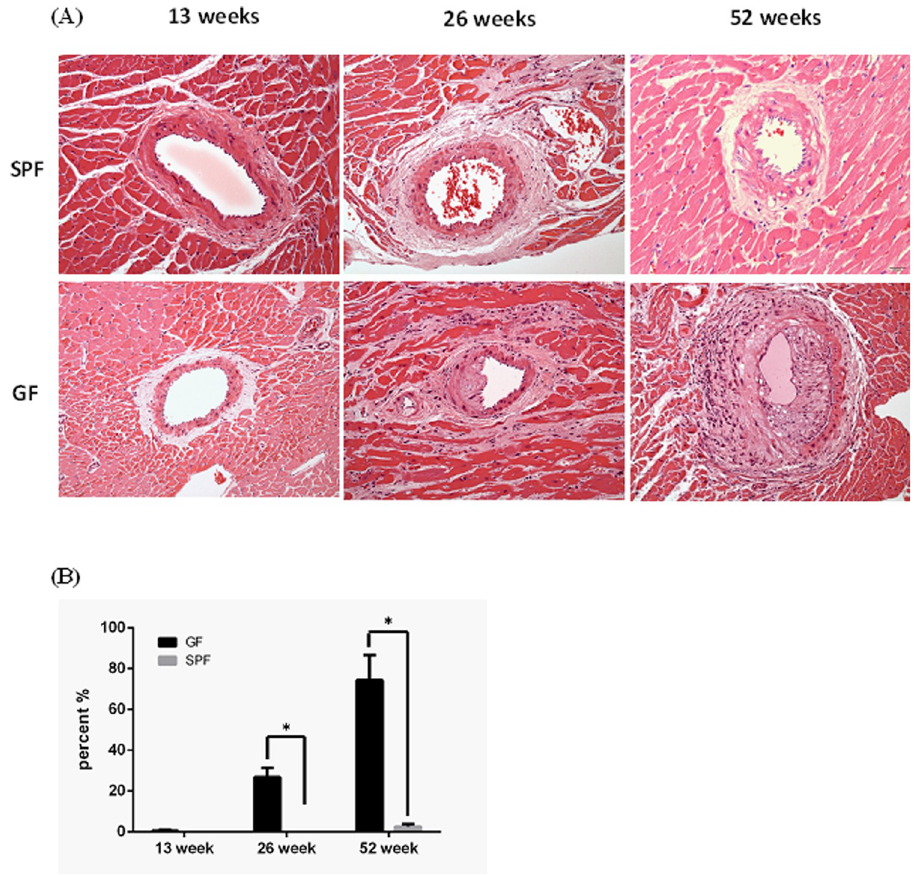
Fig 3. Atherosclerosis lesions of cardiac coronary artery of ApoE -/- rats reared under different microbial conditions. (A) The progress of cardiac atherosclerosis lesions from 12 to 52 weeks. (B) The semi-quantitative analysis of atherosclerotic lesions from 13 to 52 weeks. GF: germ free, SPF: specific pathogen free. Analyzed using Image-J